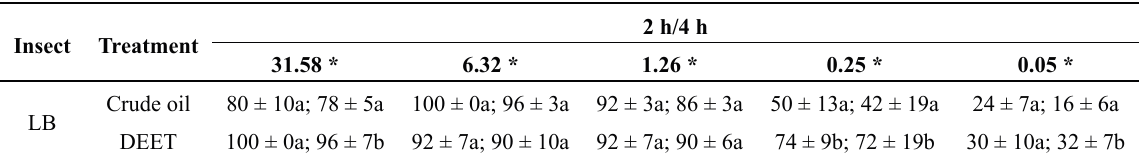
Table 4. Percentage repellency (PR) after two exposure times for the essential oil against Liposcelis bostrychophila (LB) a